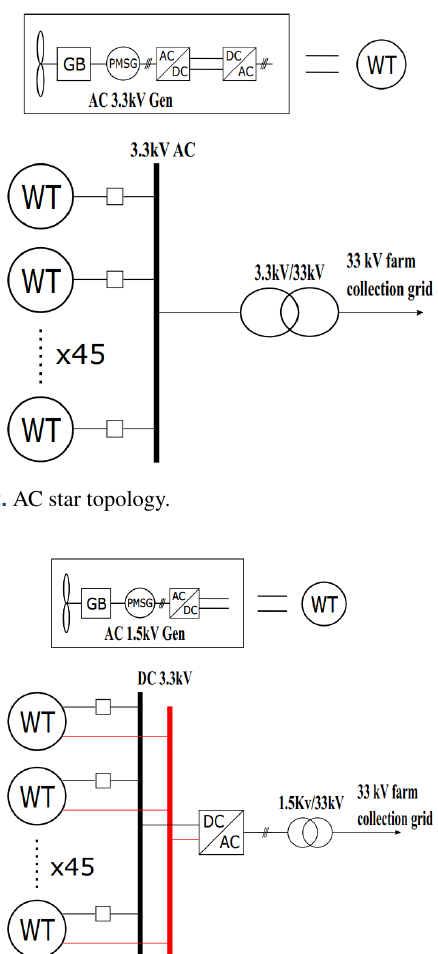
Figure 3. DC star topology.